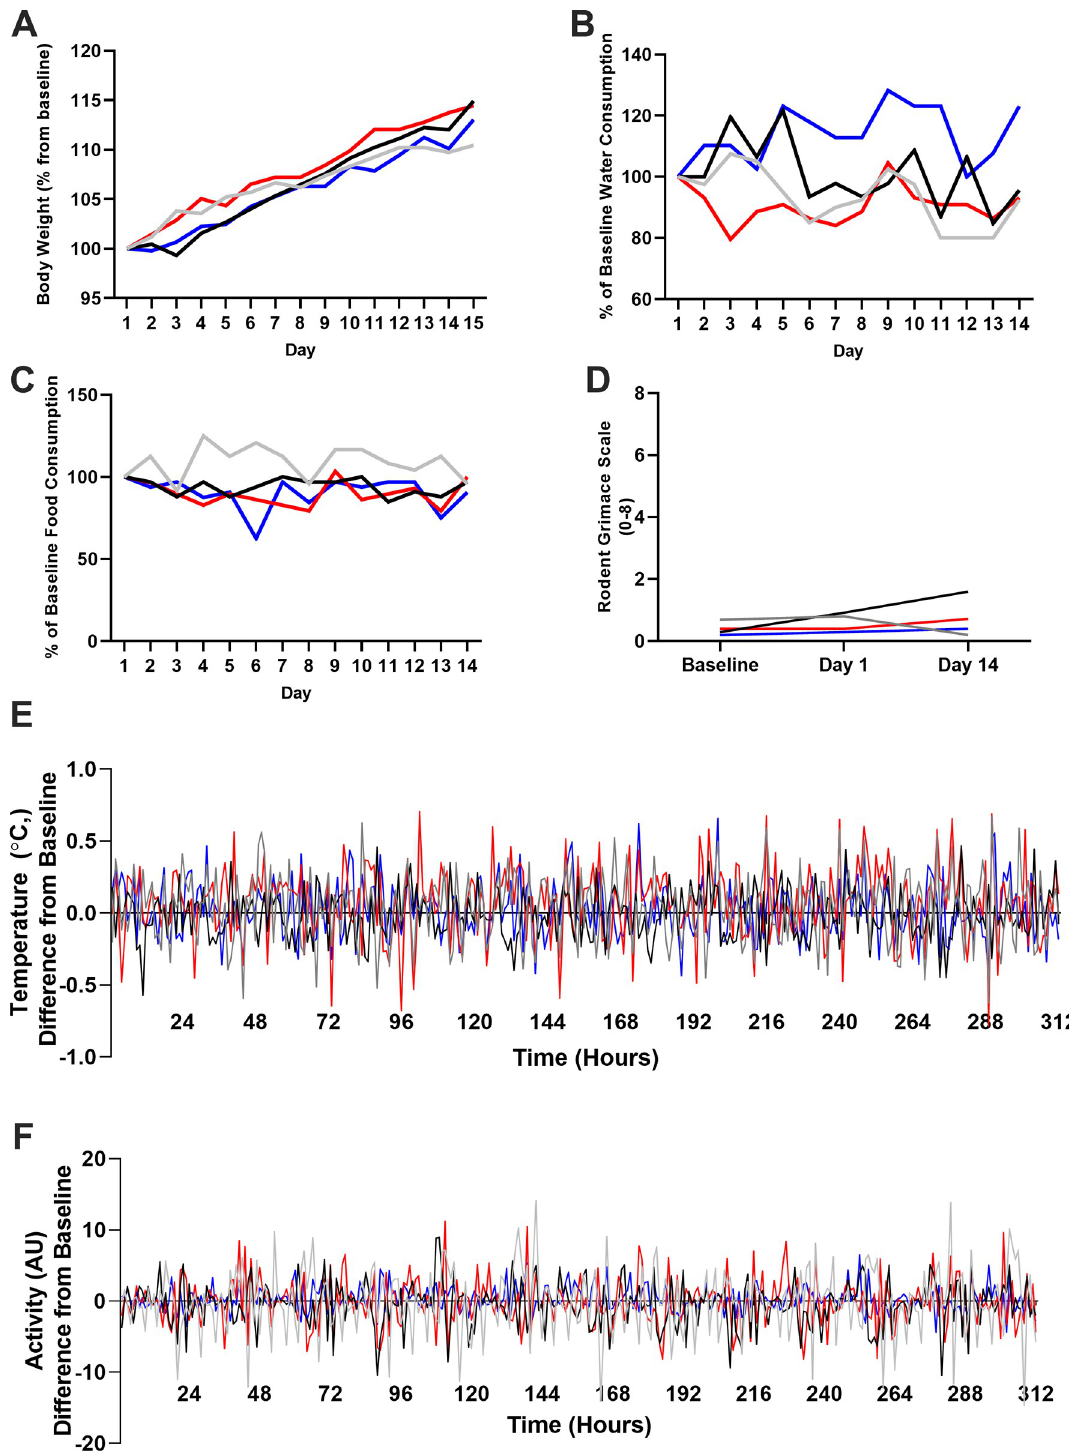
Fig 1. Experiment 1 safety measures. Body weight steadily increased in all animals (A) across experiment 1. Water (B) and food consumption (C) did not decrease by more than 20%, indicating little cause for concern. Pain (D) did not increase by more than 2 points in any animals, indicating the treatment was well tolerated. Body temperature (E) did not differ from baseline by more than 1˚C in any animals, at any point in time. Dosing did not affect observed activity levels (F). Temperature and activity are graphed as difference from baseline (averaged hourly to account for circadian rhythms), where a positive reading means that animals were hotter/ more active post-treatment. Lines represent individual animals. https://doi.org/10.1371/journal.pone.0276405.g001 PLOS ONE | https://doi.org/10.1371/journal.pone.0276405 October 18,